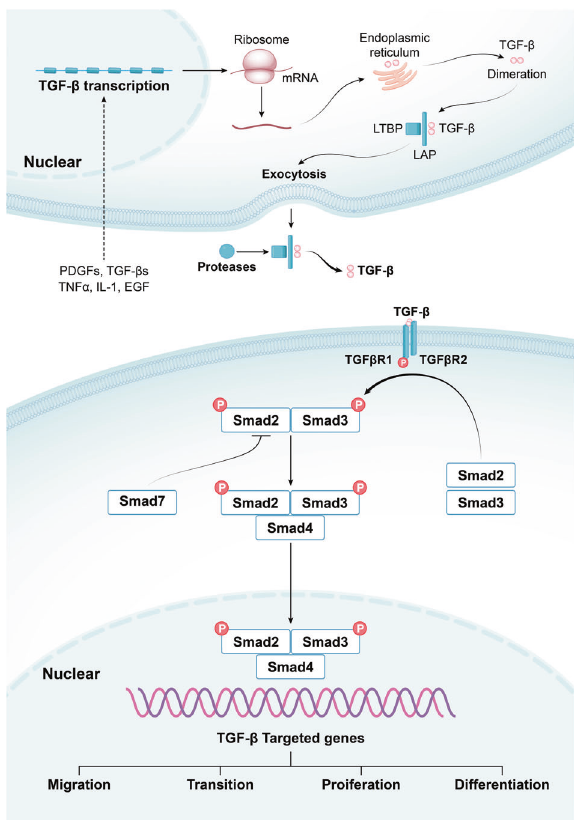
Fig. 5 Overview of canonical TGF- β /Smad signaling pathway. Various cytokines stimulate the transcipiton of TGF- β , such as PDGFs, TGF- β s, TNF- α , IL-1 β , and EGF. Pro-TGF- β is synthesized in the ribosome and endoplasmic reticulum. After dimeration, LAP binds to mature TGF- β and attaches to LTBP, entering the intercellular space through exocytosis. Actived TGF- β is released by proteases, and binds to TGF β R2 and TGF β R1. Phosphorylated TGF β R2 phosphorylates TGF β R1. TGF β R1 subsequently triggers the